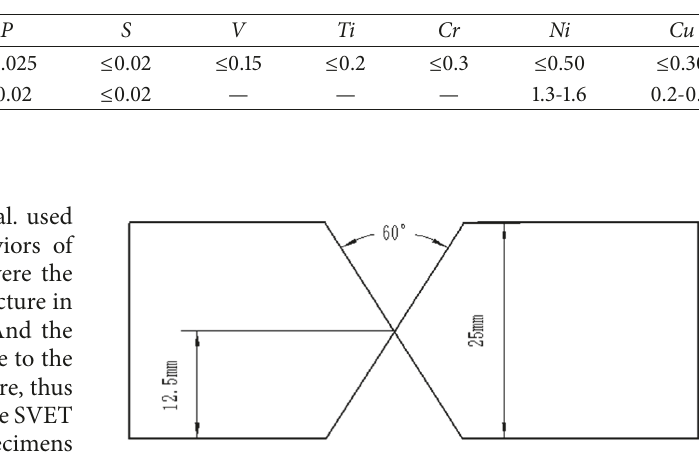
Figure 1: Schematic illustration of welded groove.